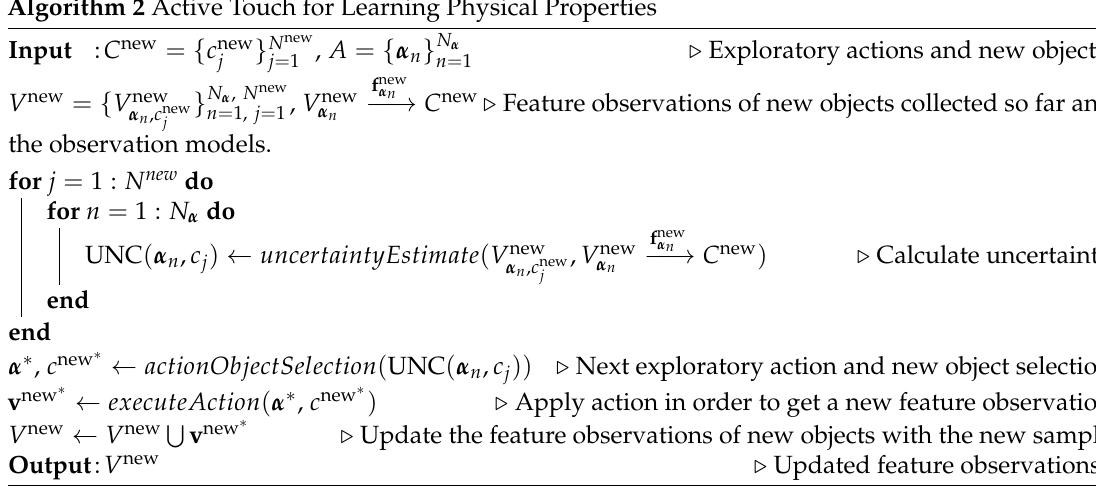
Algorithm 2 Active Touch for Learning Physical